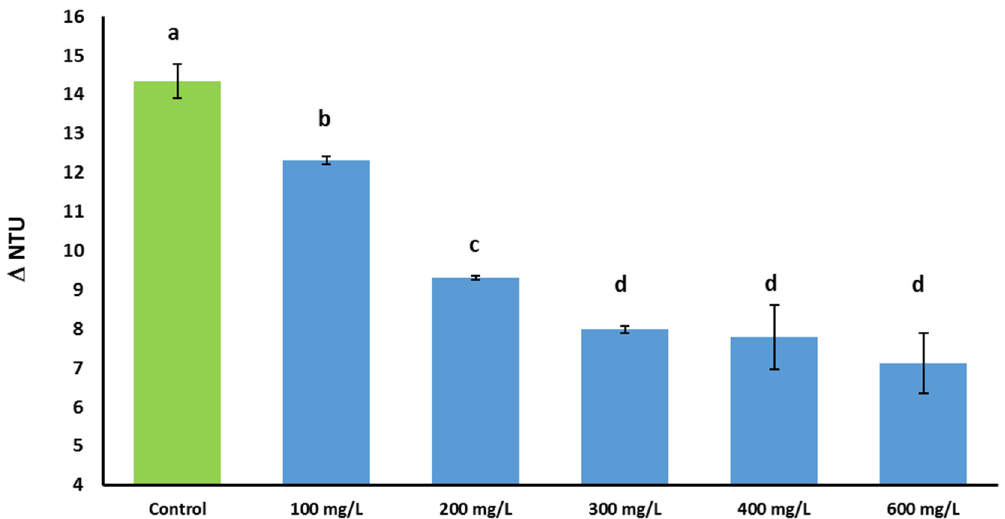
Figure 3. Haziness of Vernaccia wine added with increasing amounts of UFS (from 100 mg/L to 600 mg/L) as obtained by nephelometry after heating treatment. Control: Vernaccia wine without UFS. Error bars represent standard deviation of three independent experiments, each carried out in duplicate. Values displaying different letters (a, b, c, d) are significantly different (One-way ANOVA, Tukey’s post-test, p = 0.05).